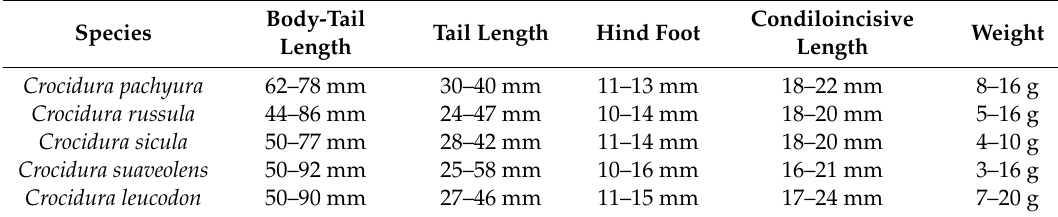
Table 4. Body measurements of Crocidura species occurring in Italy and neighbouring countries [20,21].